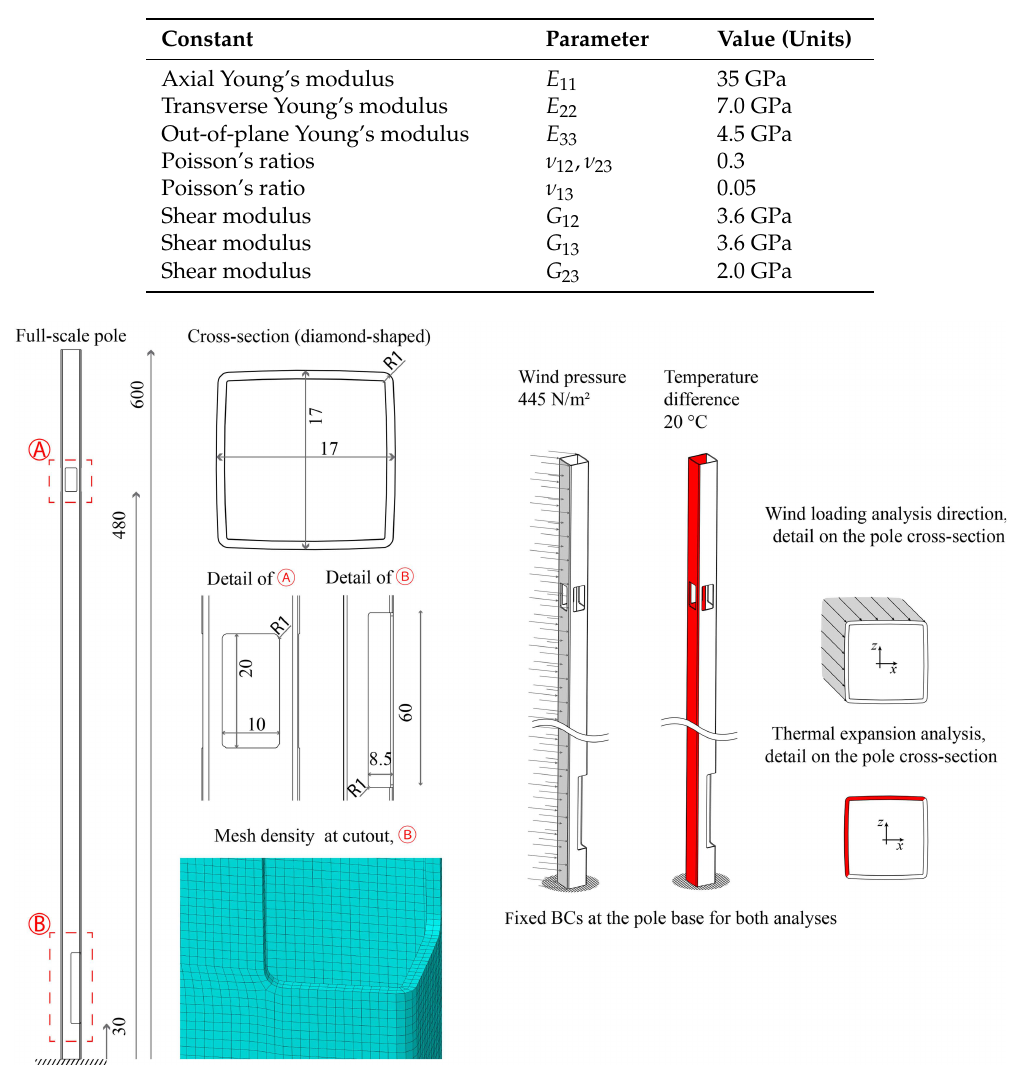
Table 1. Elastic constants of the GFRP (unidirectionally reinforced layer) used in this work for the pole shaft FEA [27,28].